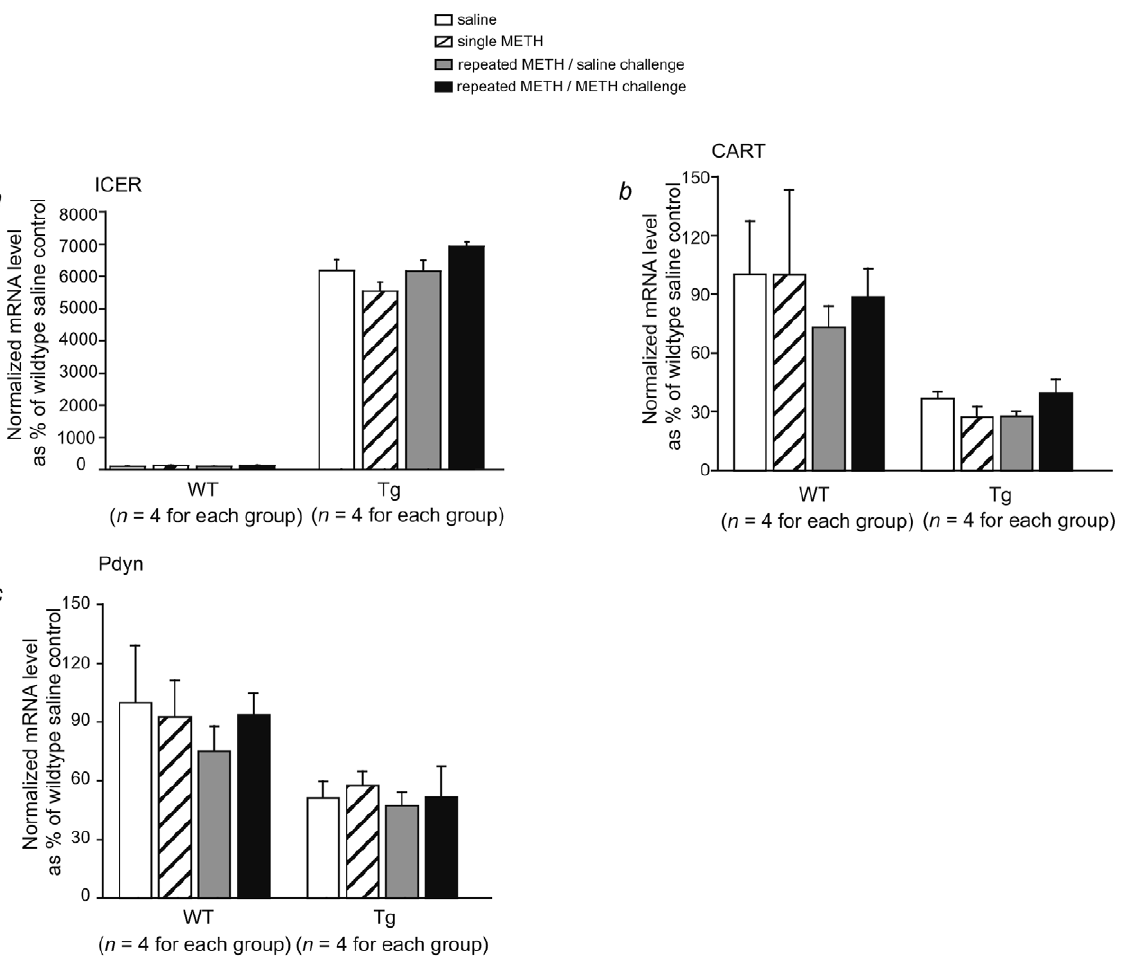
Figure 4. ICER, CART, and Pdyn mRNA levels in the CPu after single and repeated METH treatment. The mice were administered METH (1 mg/kg, i.p.) or saline once or received METH (1 mg/kg, i.p.) once every other day from Day 1 to Day 13 and challenged with saline or METH (1 mg/ kg, i.p.) on Day 20 after a 7 day drug-free period. The mice were decapitated 1 h after the last METH or saline treatment. a . ICER mRNA expression in the CPu in wildtype (WT) and ICER I-overexpressing (Tg) mice. The data are expressed as mean 6 SEM ( n =4). b . CART mRNA expression in the CPu after single and repeated METH treatment. The data are expressed as mean 6 SEM ( n =4). c . Pdyn mRNA expression in the CPu after single and repeated METH treatment. The data are expressed as mean 6 SEM ( n